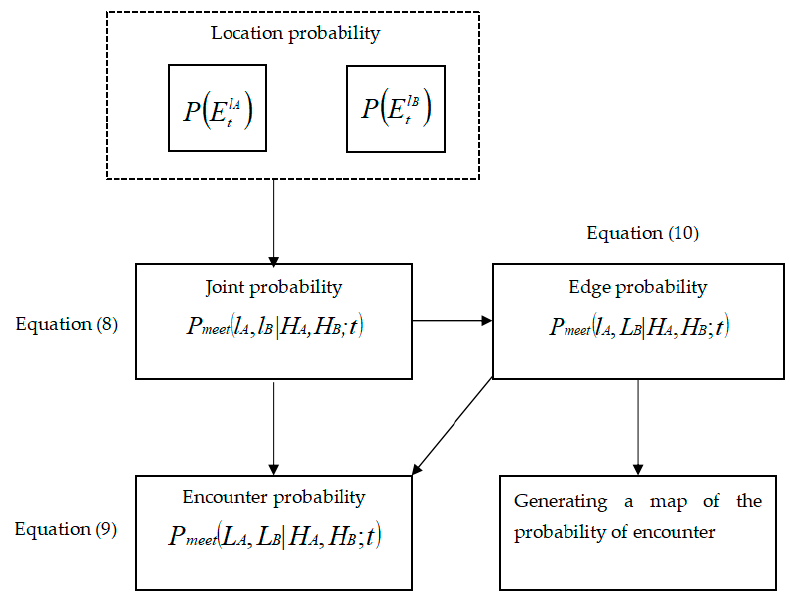
Figure 5. The probability calculations.